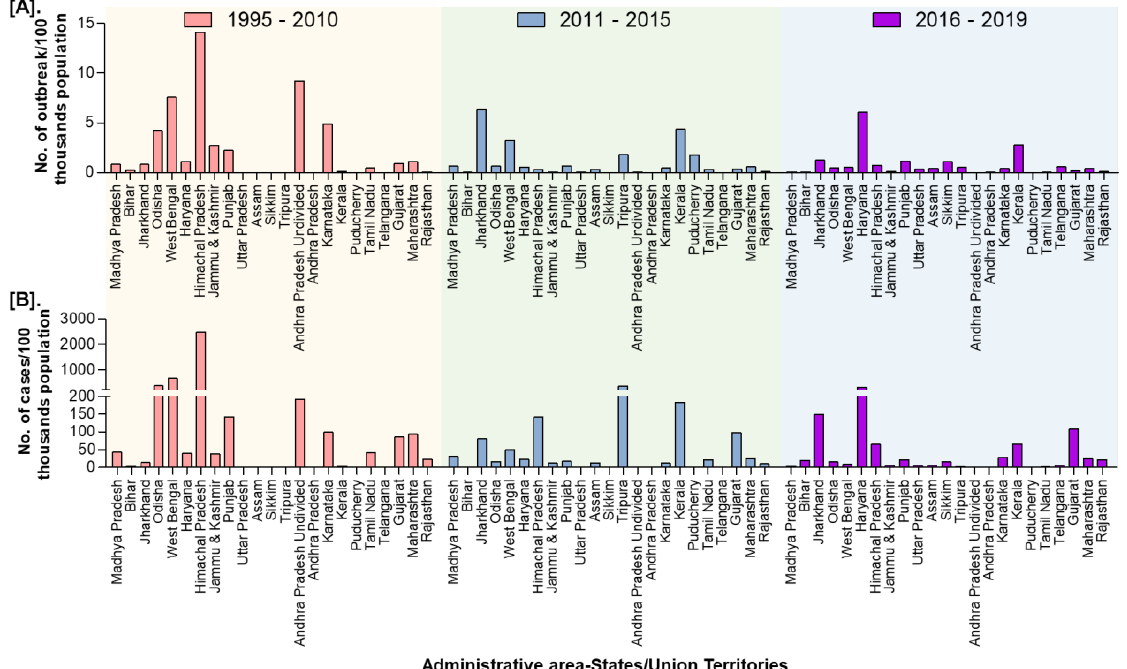
Figure 4. State-wise proportion of the cumulative PPR reports in India (1995–2019) with the population. ( A ). Outbreaks ( B ). Cases. Himachal Pradesh, West Bengal, and Odisha were the top three states reporting the highest number of cases per 100 thousand population during 1995–2010, whereas Tripura & Kerala and Jharkhand & Haryana states were highest during 2011-15 and 2016–2019 periods, respectively.